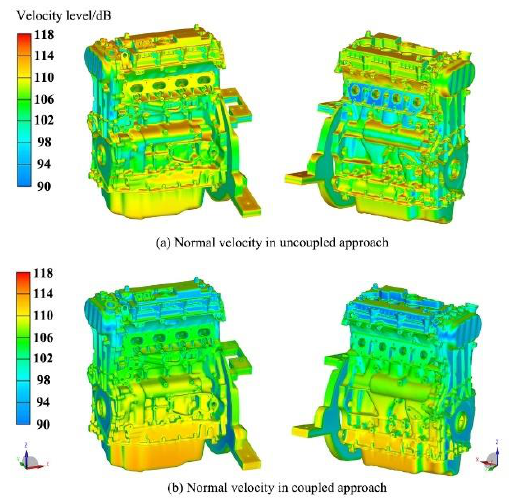
Figure 27. The colormaps of the vibration normal velocity level comparison between the two approaches at the frequency of 83.3 Hz.